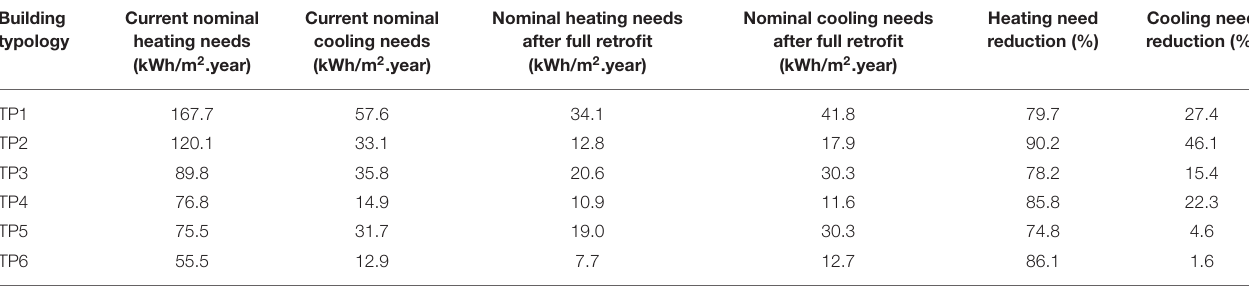
TABLE 4 | Annual nominal heating and cooling dwelling energy needs before and after the retrofit. Building typology